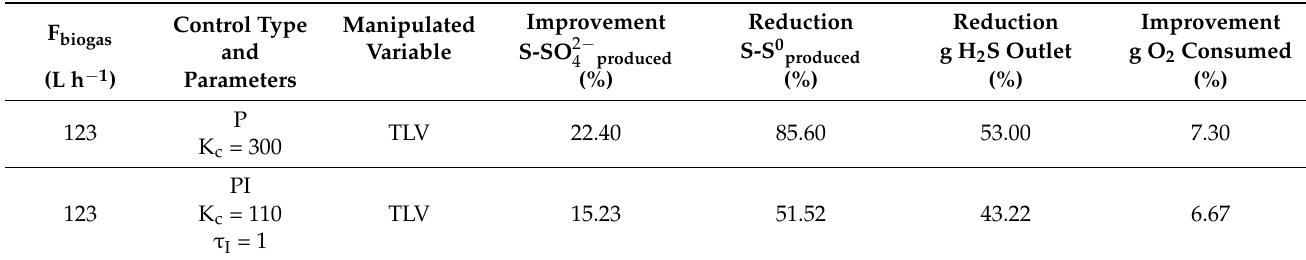
Table 9. Improvement on the main process performance variables for TLV control strategy facing biogas flowrate changes using a using a P and PI feedback controllers. F